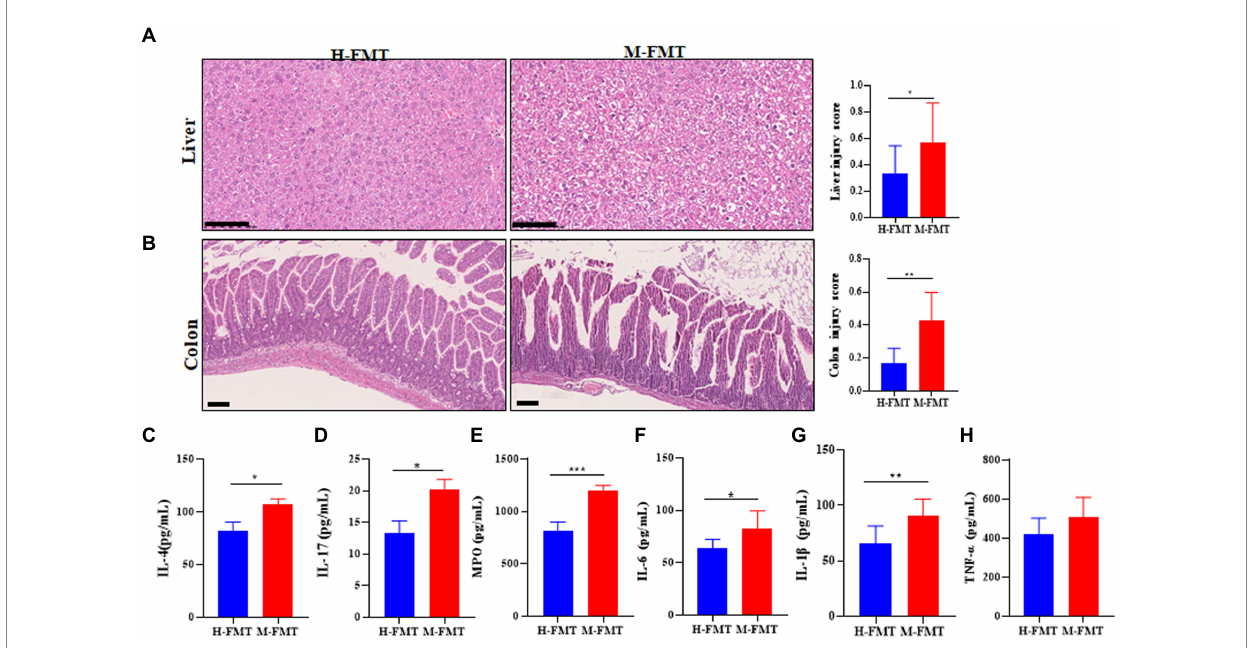
FIGURE 3 The murine inflammation induced by lactation mastitis patient’s intestinal microbiota seemed pervasive. (A) Representative photomicrographs of the hematoxylin–eosin-stained liver (×200) (left). The injury score of the liver (right). (B) Representative photomicrographs of hematoxylin–eosin-stained colon (×100) (left). The injury score of colons (right). Quantification of inflammatory cytokines including IL-4 (C) , IL-17 (D) , MPO (E) , IL-6 (F) , IL-1 β (G) , and TNF- α (H) in serum using ELISA. The assays were all performed for the two groups of mice on Day 65 after FMT. The data represent the means ±SEMs ( n = 8–10 mice per group). * p < 0.05, ** p < 0.01, *** p < 0.001 by t -test. Scale bar, 100 μ m.